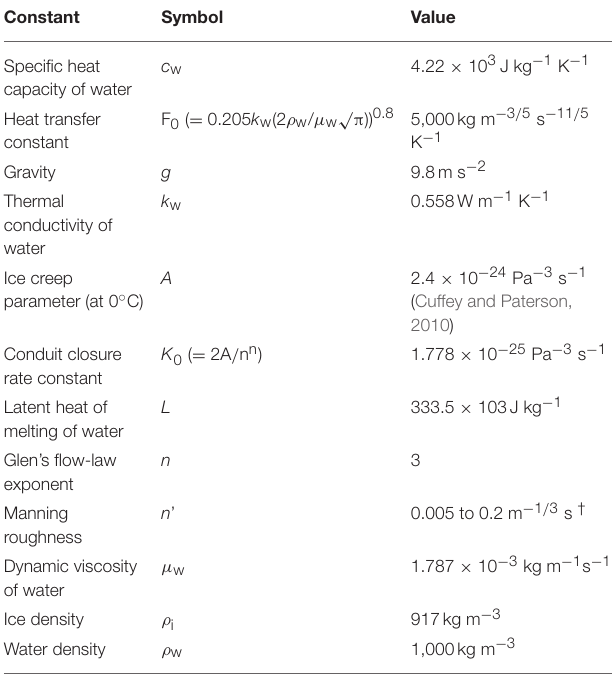
TABLE 2 | Phenomenological constants in our